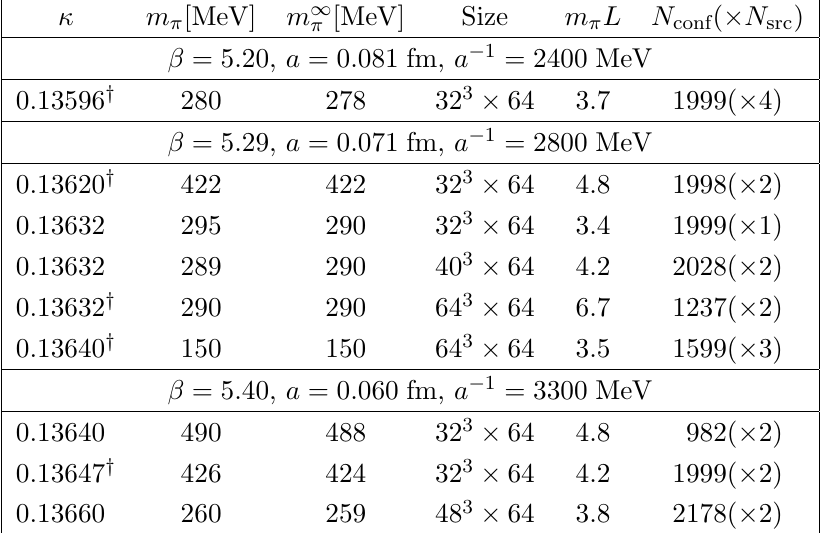
determined (cid:25)